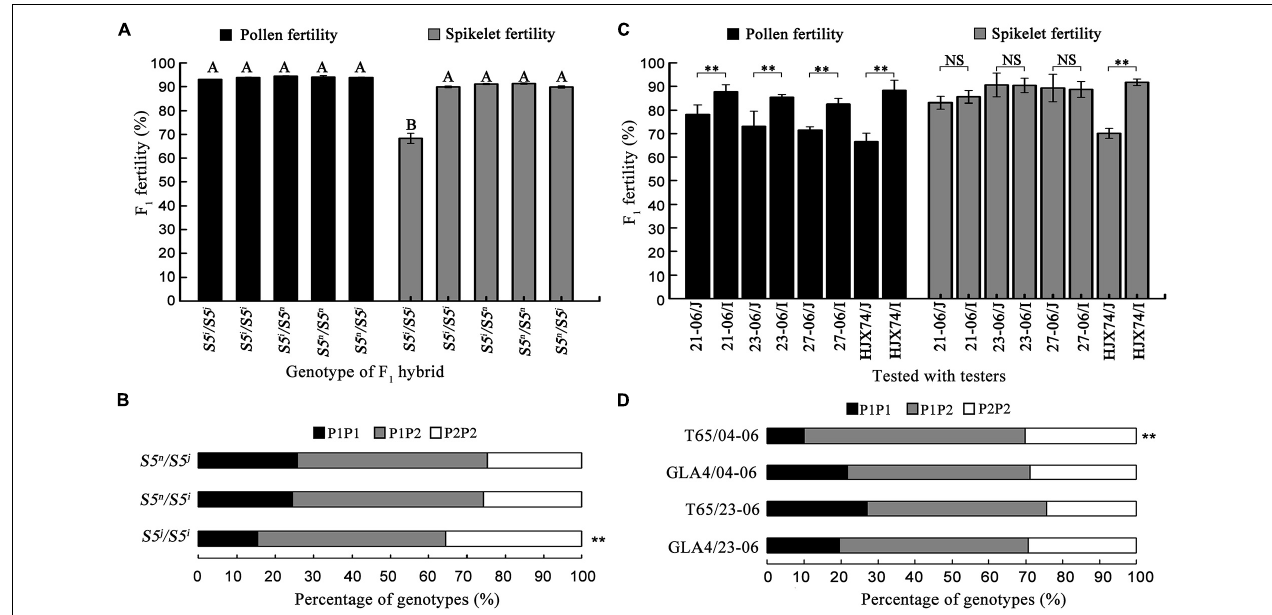
FIGURE 3 | Genotypes and genetic effects of the S5 gene on chromosomal substitution segments of SSSLs with the HJX74 genetic background. (A) Pollen fertility and spikelet fertility in F 1 hybrids from the crosses between SSSLs and different S5 genotypes. (B) Segregation ratios of S5 genotypes in F 2 populations from different crosses. (C) Pollen fertility and spikelet fertility in F 1 hybrids from crosses between SSSLs (21-06, 23-06, and 27-06) and testers. I, indica testers; J, japonica testers. Capital letters indicate statistical differences at the 0.01 probability level. (D) Segregation ratios of S5 genotypes in F 2 populations from crosses between SSSLs and testers. P1P1, Genotype of tester; P1P2, Heterozygous genotypes; P2P2, Genotypes of SSSLs. ∗∗ , Significant difference at 0.01 probability level. NS, No